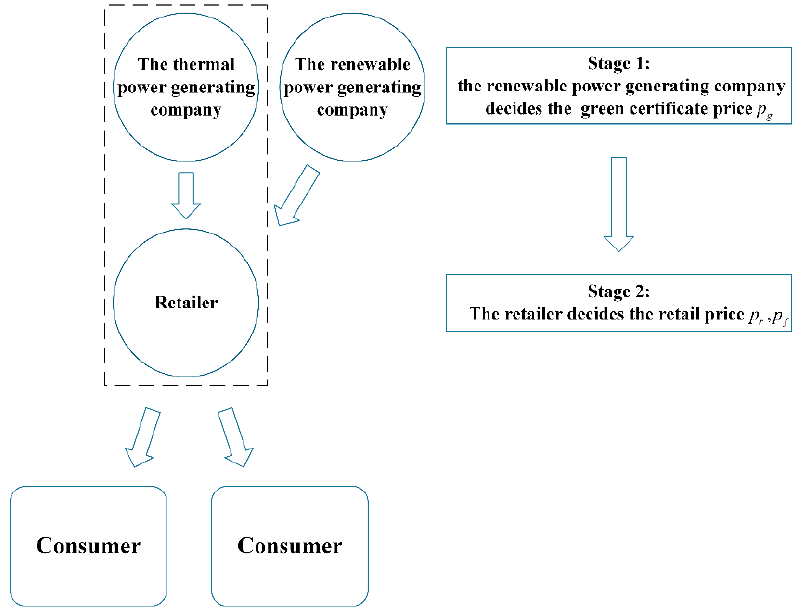
Figure 2. The supply chain network structure of the centralized decision in case 2. 158